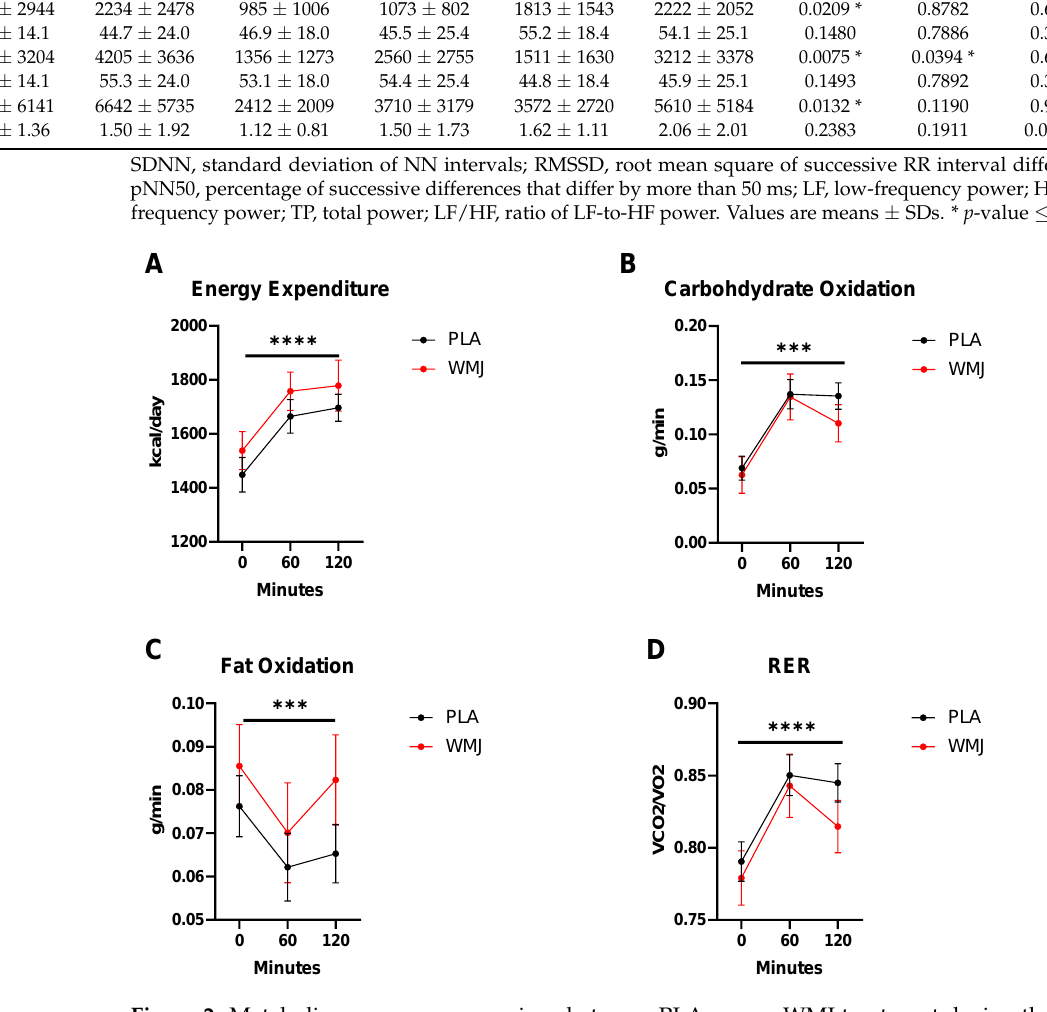
0.100 SDNN, standard deviation of NN intervals; RMSSD, root mean square of successive RR interval differences; pNN50, percentage of successive differences that differ by more than 50 ms; LF, low- frequency power; HF, high-frequency power; TP, total power; LF/HF, ratio of LF-to-HF power. Val- ues are means ± SDs. * p - value ≤ 0.05.